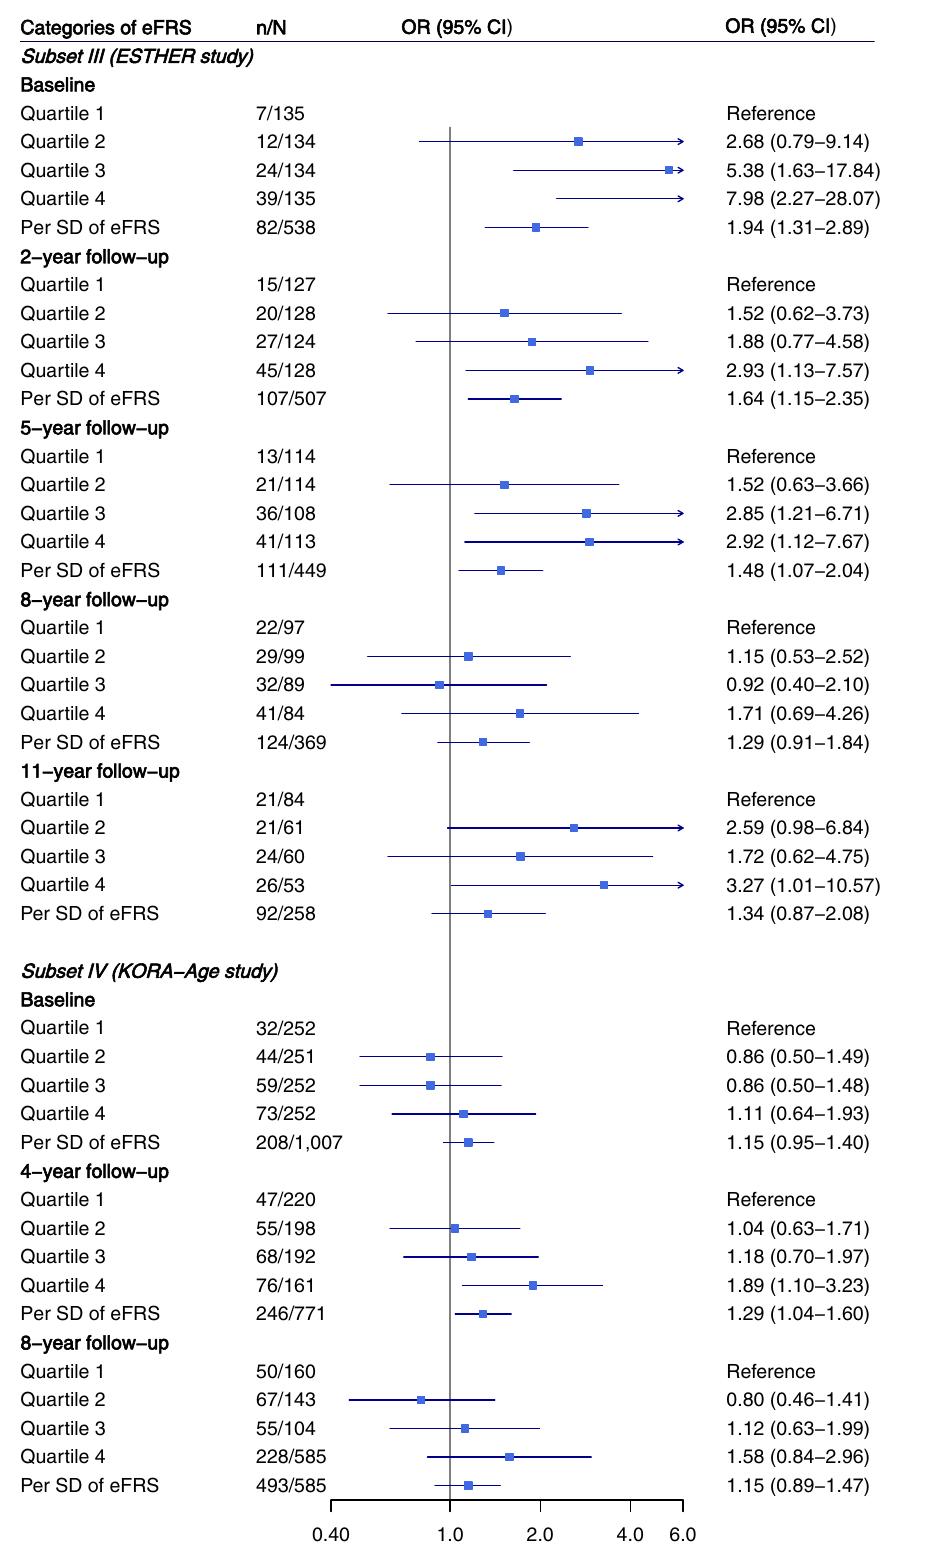
Fig.2|Associationofepigeneticfrailtyriskscorewithbeingfrailatfollow-ups. Vertical ticks within the blue boxes and horizontal lines show the OR and 95% CI. Modelswereadjustedforage,sex,leukocytecomposition,batch,baselinesmoking